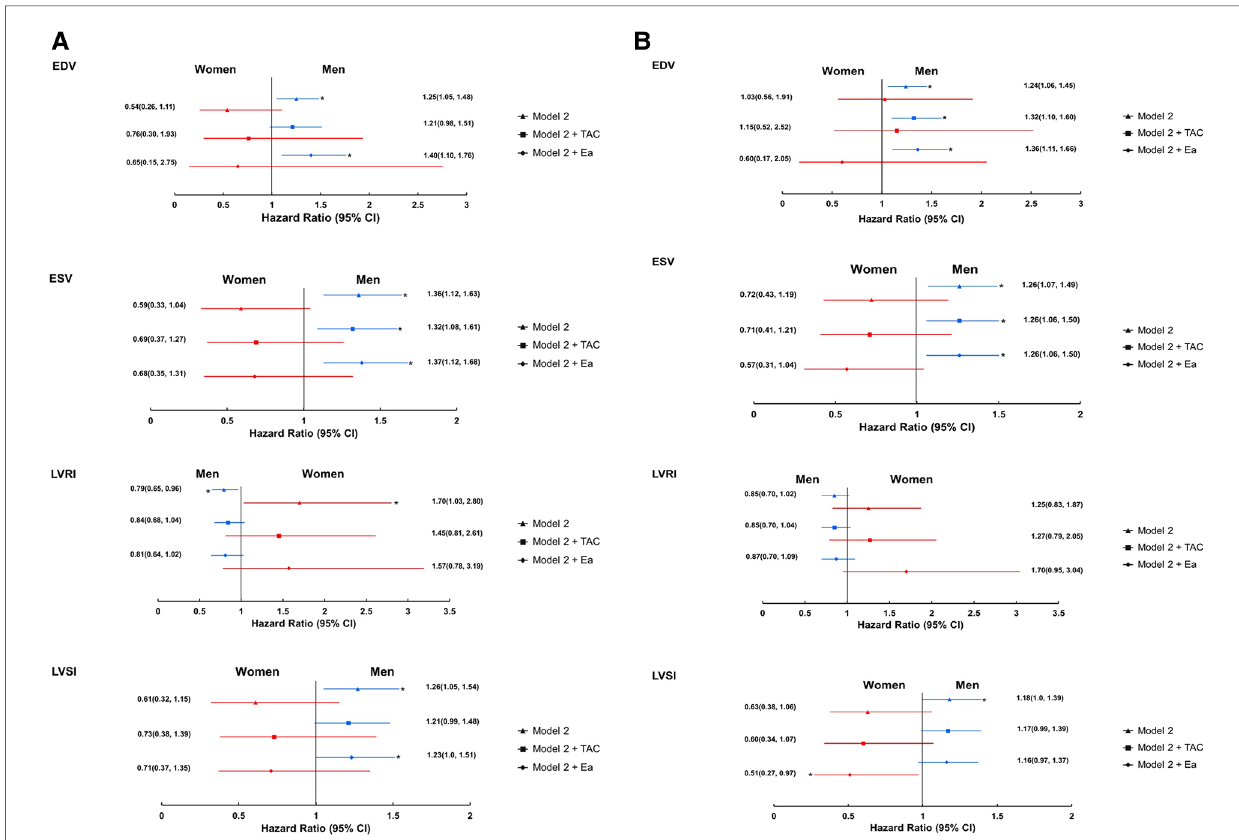
FIGURE 3 Forest plots showing the associations between 3DE-derived LV measures and all-cause mortality ( A ) and composite cardiovascular endpoint ( B ) strati fi ed by sex; role of macro-vascular disease (imputed data). *Indicates p <0.05. Ea, effective arterial elastance; and TAC, total arterial compliance. Remaining abbreviations as in Table 2 . Footnotes as in Figure 1